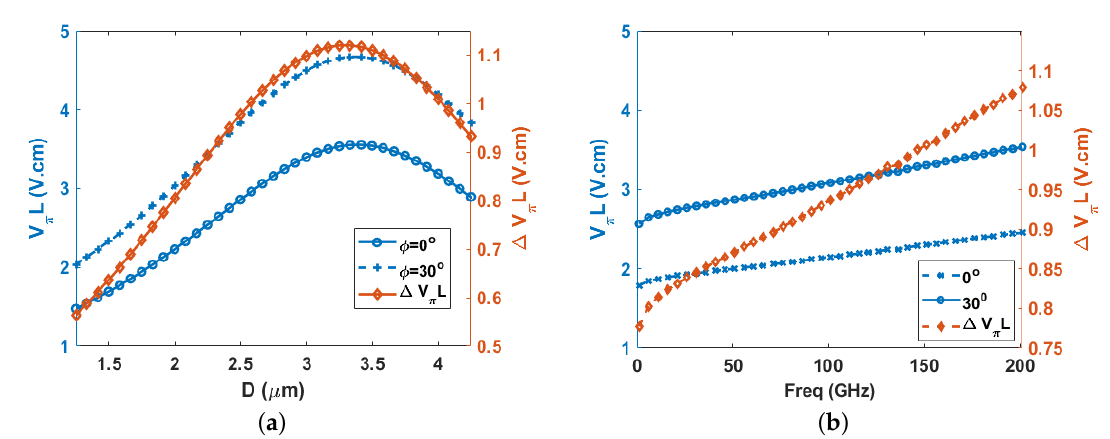
Figure 7. V π L and ∆ V π L for 0 ◦ and 30 ◦ versus ( a ) D and ( b ) RF